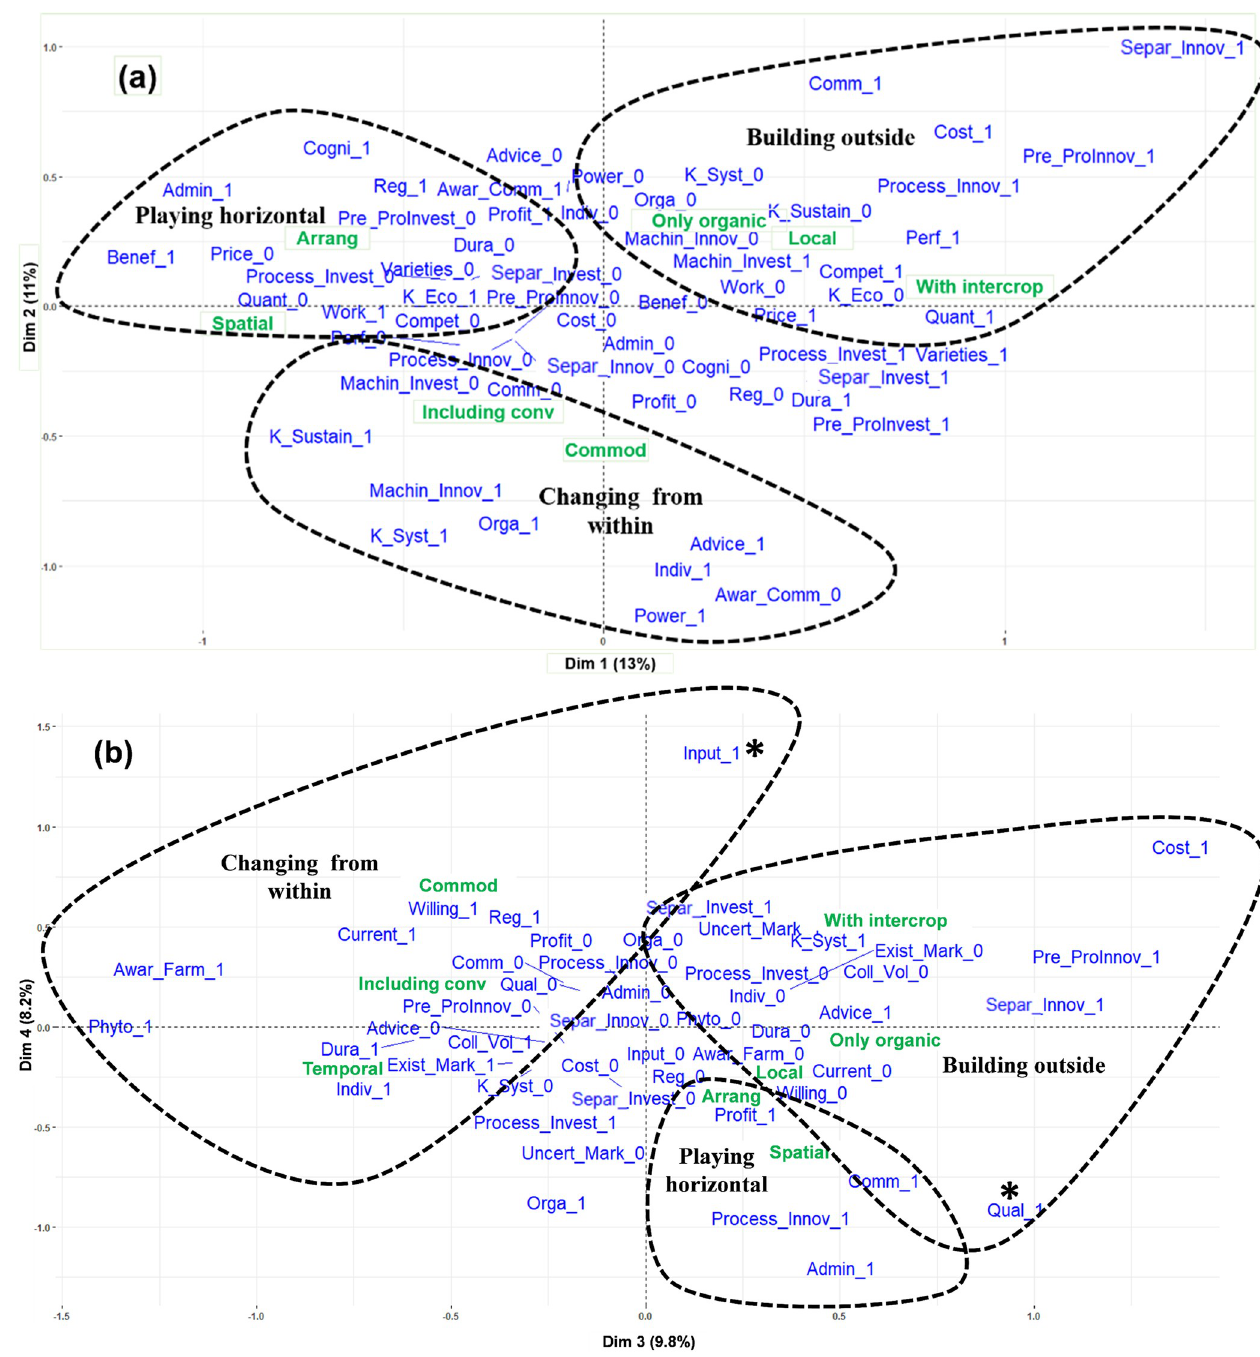
Fig 4. MCA projection of barriers (in blue) and supplementary qualitative variables related to the food system innovation setting (green) on axes 1–2 (a) and 3–4 (b). The codes used for supplementary variables are presented in Table 1 and for barriers in Table 2. For barriers, “1” denotes presence and “0” absence. On each 2-axis projection are presented only the barriers and supplementary variables linked to at least one axis. Barriers and supplementary variables were grouped visually into three ideal-types, as shown on the Figure. Although informed by the MCA, the limits of each group were drawn based on the qualitative analysis of interviews carried out with the different innovation teams. This sometimes led to the integration of barriers that were quite distant to the rest of the group ( � ). Ideal-types and their corresponding barriers are summarised in Table 2.